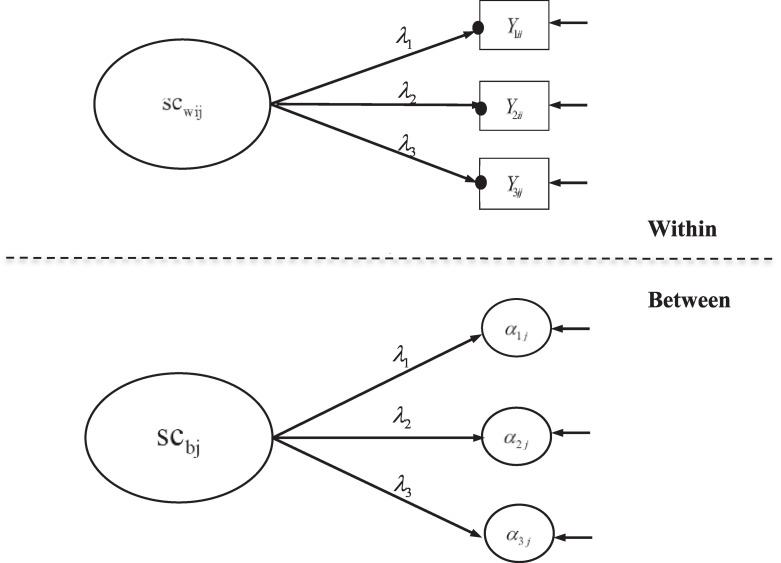
Statistical Model 1 – two-level confirmatory factor analysis model with multilevel measurement invariance of mathematics self-concept. The solid dots indicate random intercepts for different classes. Reprinted with permission from Wang and Bergin (2017); Copyright 2017 by Elsevier.